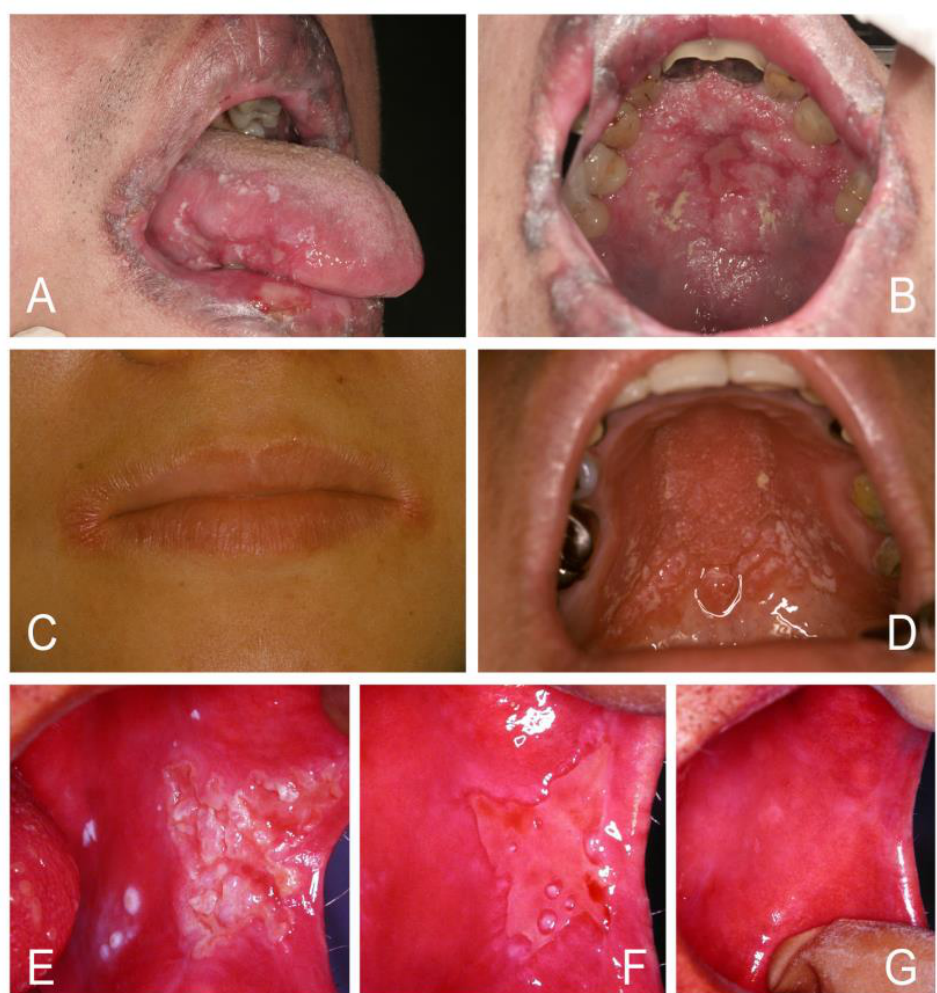
Figure 5. ( A , B ) Pseudomembranous candidosis and granular type or inflammatory papillary hyperplastic candidosis of palate and recurrent cheilocandidosis with heavy lip stain in a 35-year-old man showing systemic lupus erythematosus. ( C , D ) Angular cheilitis and inflammatory papillary hyperplastic candidosis of palate in a 25-year-old woman showing iron deficiency and moderate anemia. ( E ) Pseudomembranous candidosis and inflammatory papillary hyperplastic candidosis of buccal mucosa in a 50-year-old man with diabetes mellitus who showed dramatic response to nystatin therapy 5 days later ( F ) and complete response to therapy 10 days later ( G ). Oropharyngeal candidosis may show lesions involving the back third of the